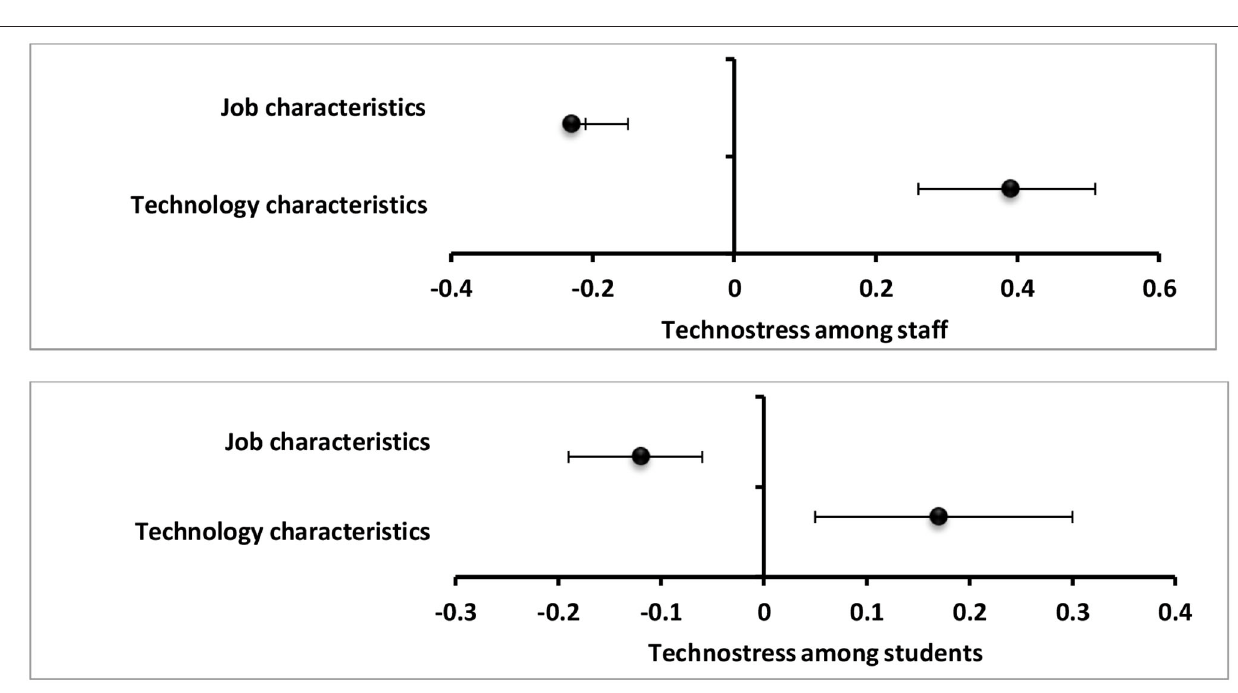
FIGURE 11 | Values of β and CI 95% for linear regression analysis of job characteristics and technology characteristics as predictors to total techno-stress score among staff and